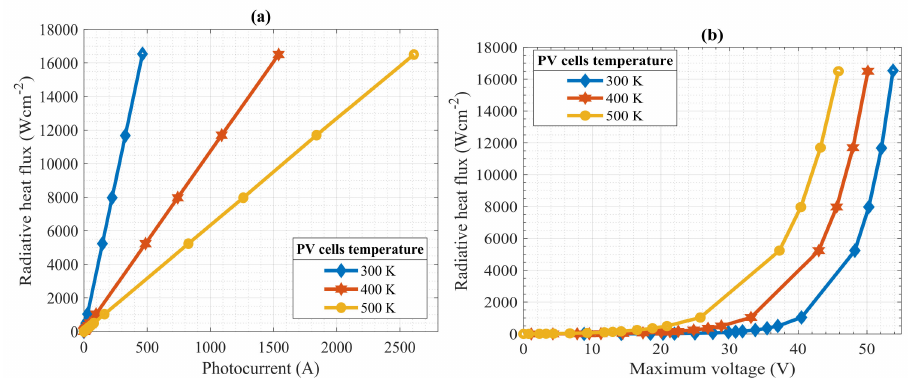
Figure 5. Relationshipbetween( a )photocurrentandradiativeheatflux,( b )maximumvoltage,andradiative heat flux for PV cells temperatures at 300, 400, and 500 K.